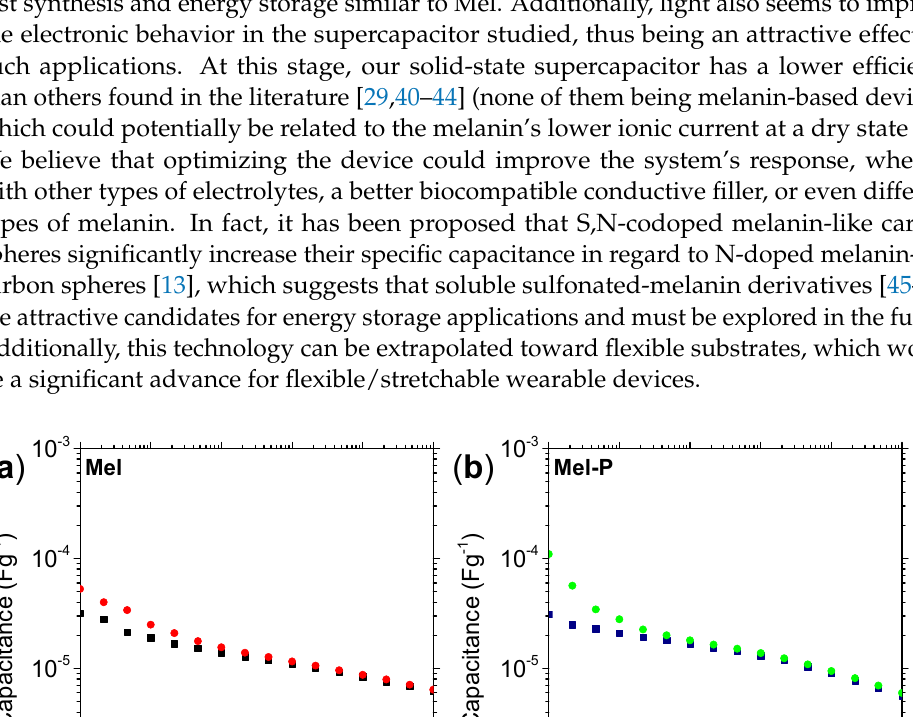
Figure S3. SEM images of (a) Mel and (b) Mel-P without MWCNT. Figure S4. Cyclic voltammogram spectra at different scan rates under illumination for (a) Mel and (b) Mel-P. Figure S5. Specific capacitance as a function of scan rate of (a) Mel and (b) Mel-P electrodes. Figure S6. Extrapolation of the galvanostatic charge over time. These curves were obtained by fitting the ex-perimental galvanostatic charge curves in Figure 3a,b (in the main text) with an exponential func-tion. The fitting parameters were then used as fixed specs to estimate the curve as time increases. Figure S7. Estimation of the supercapacitor’s leakage current. The symbols are the experimental data and